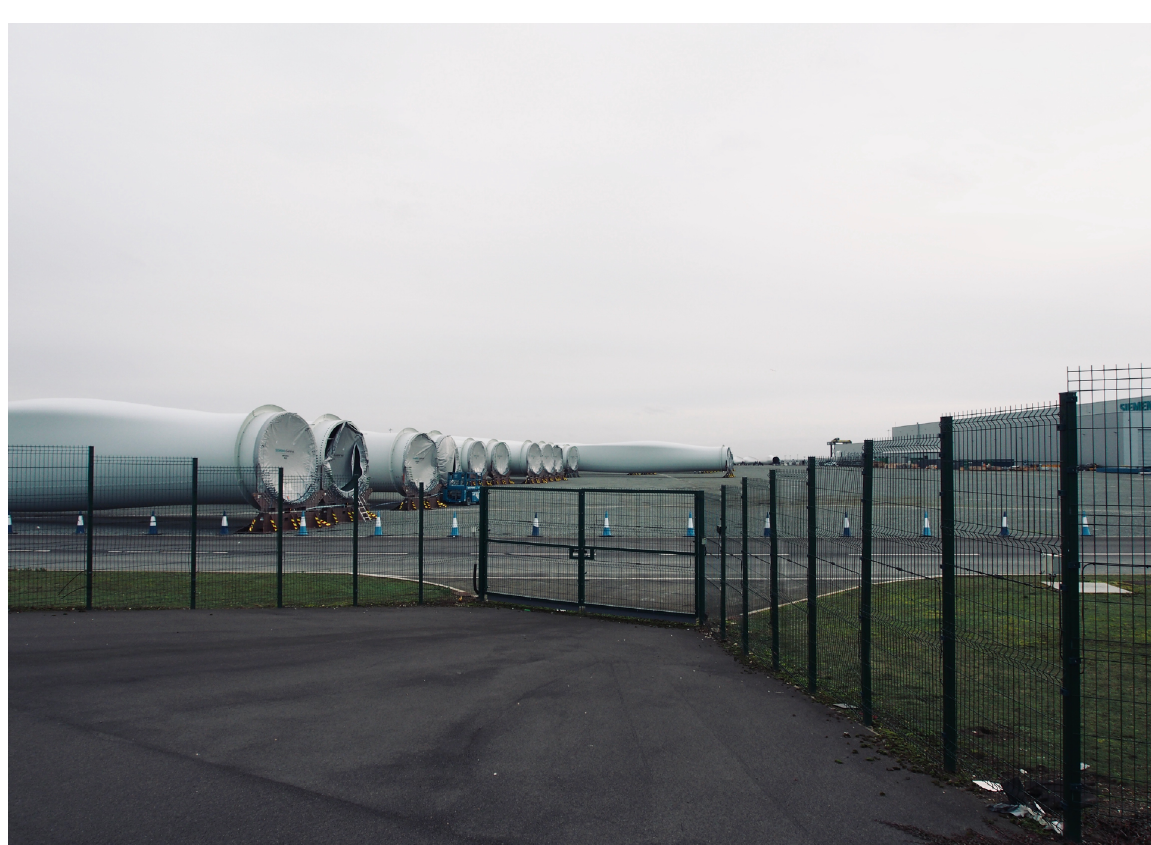
Siemens fenced-off industrial grounds, original photo by author,